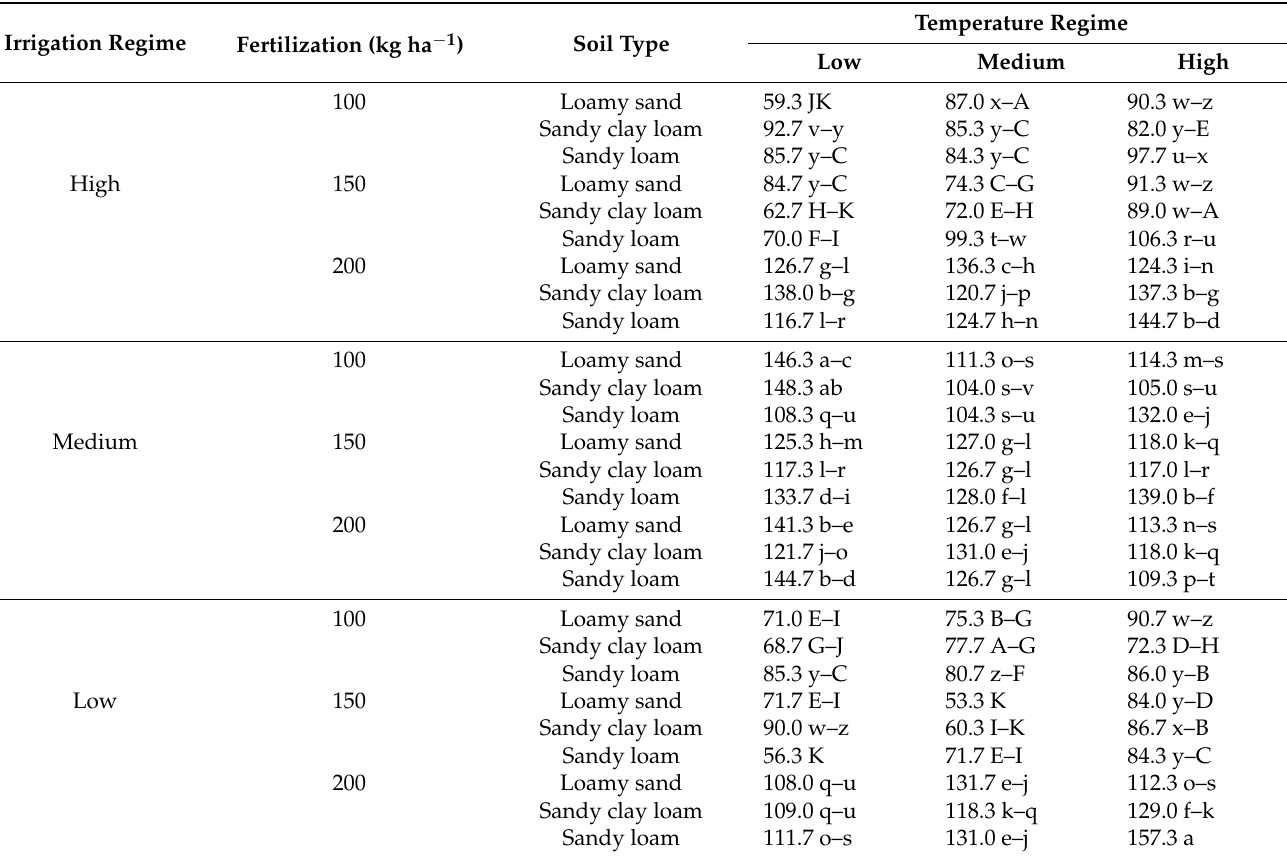
Table 6. Interactive effect of air temperature and irrigation regimes, nitrogen fertilizer application, and soil type on herbage yield (g/plant).